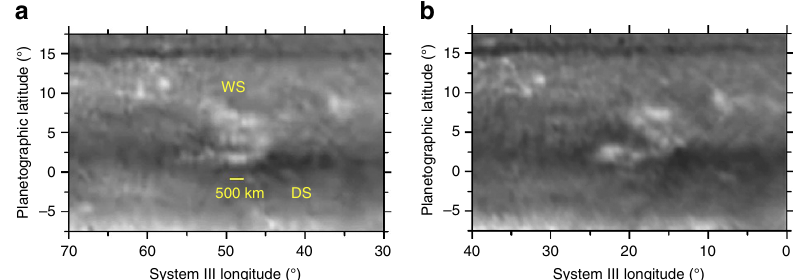
Figure 4 | Morphology of the white spot and dark spot. Morphology and changes in the white (WS) and dark (DS) spots as observed with the HST-WFC3 at a wavelength of 750nm in images separated by 20.6h on: ( a ) 29 June and ( b ) 30 June. Image details are given in Supplementary Table